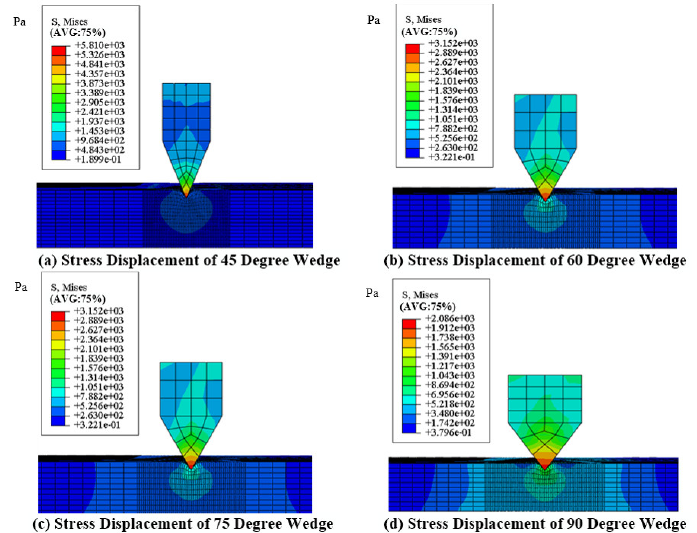
Figure 14. Stress Distribution in Section of Four Kinds of Tooth Angle Non-rigid Wedge after Embedding with 45 ◦ , 60 ◦ , 75 ◦ and 90 ◦ Tooth Angle.